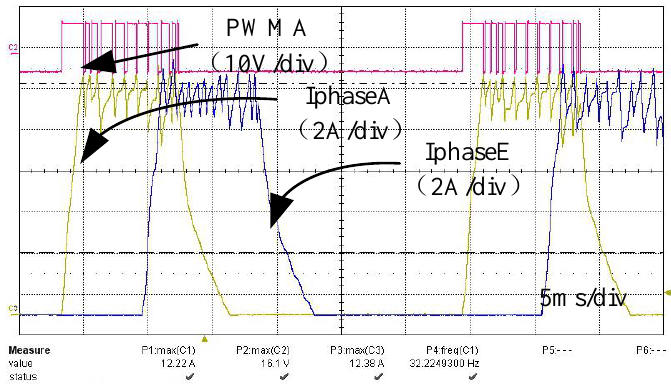
Figure 13. CCC drive control waveform.